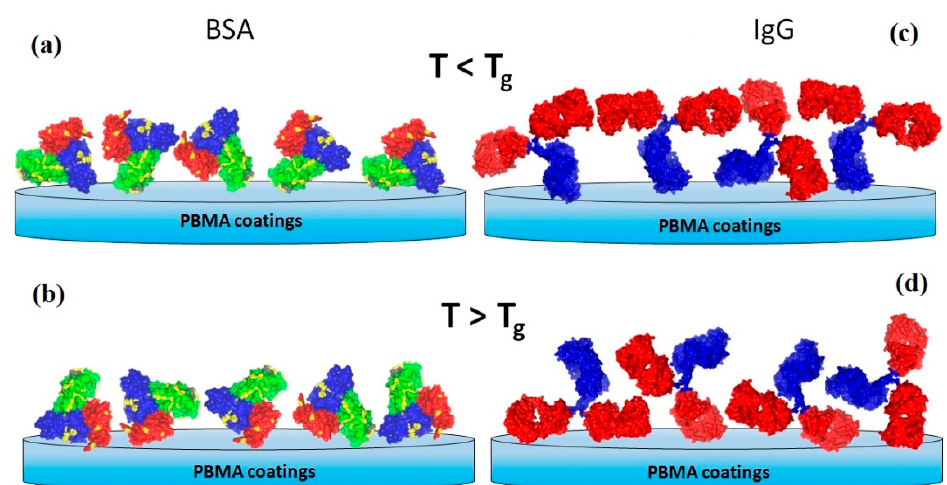
Figure 13. Orientation of the BSA and IgG proteins adsorbed to PBMA-based TRPC at a temperature below ( a , c ) and above ( b , d ) its glass transition (Tg). The different domains of BSA (red—Albumin 1, blue—Albumin 2, and green—Albumin 3) and IgG (red—Fab, blue—Fc) are distinguished by colors (modified with permission from